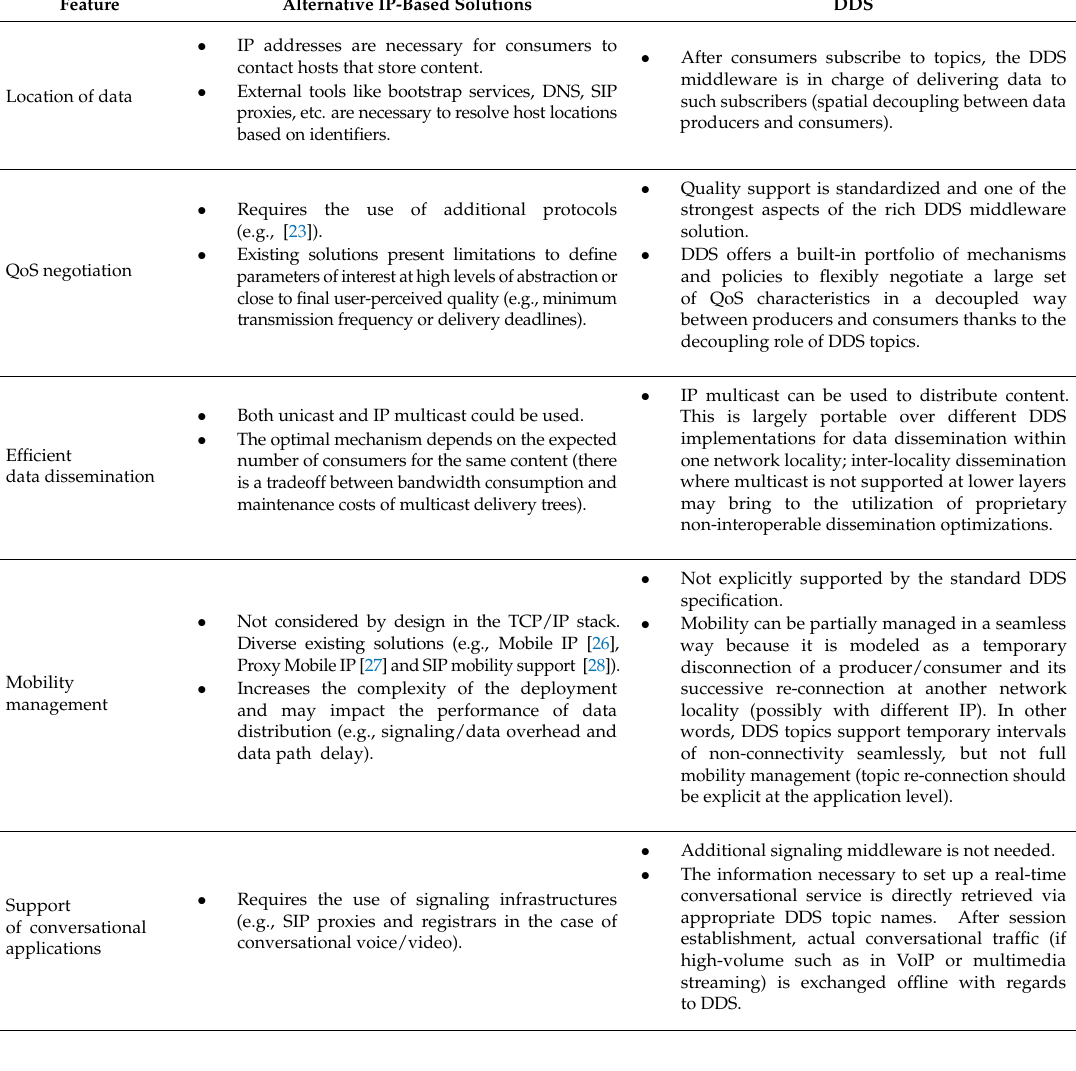
Table 1. Concise synoptic comparison of the overviewed